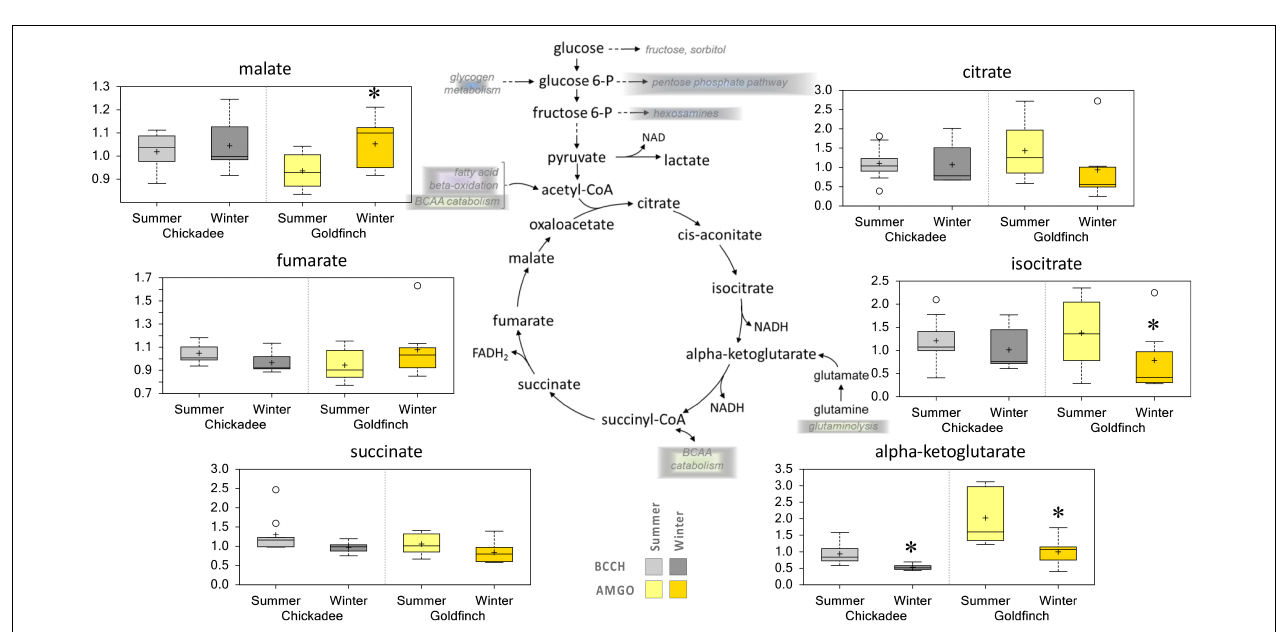
FIGURE 5 | Differences in the abundances of metabolites involved in glucose metabolism in pectoralis muscle of Black-Capped Chickadee (BCCH) and American Goldfinch (AMGO). The X -axis represents the species and the seasons sampled. The Y -axis box plots indicate the scaled intensity mean (+) and median (-) values: upper and lower ranges of boxes indicate upper and lower quartiles, respectively; upper and lower whiskers indicate the maximum and minimum distributions of the data; small circles represent outlying data points. ∗ Significantly ( p < 0.05 and q < 0.10) different compared to the other season within the species.